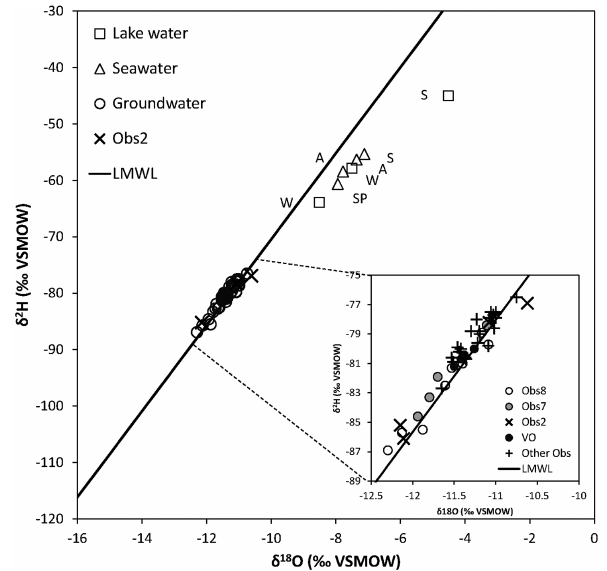
Figure 5. Plot of the δ 2 H and δ 18 O data for lake water, seawater, groundwater from the observation wells (Obs), and the water intake well (VO) from Santala during 2012 with the Finnish local mete- oric water line (LMWL) for comparison. Labels at surface water in- dicate the sampling period: S = summer, SP = spring, A = autumn and W = winter. Locations of water samplings are showed in Fig. 1.